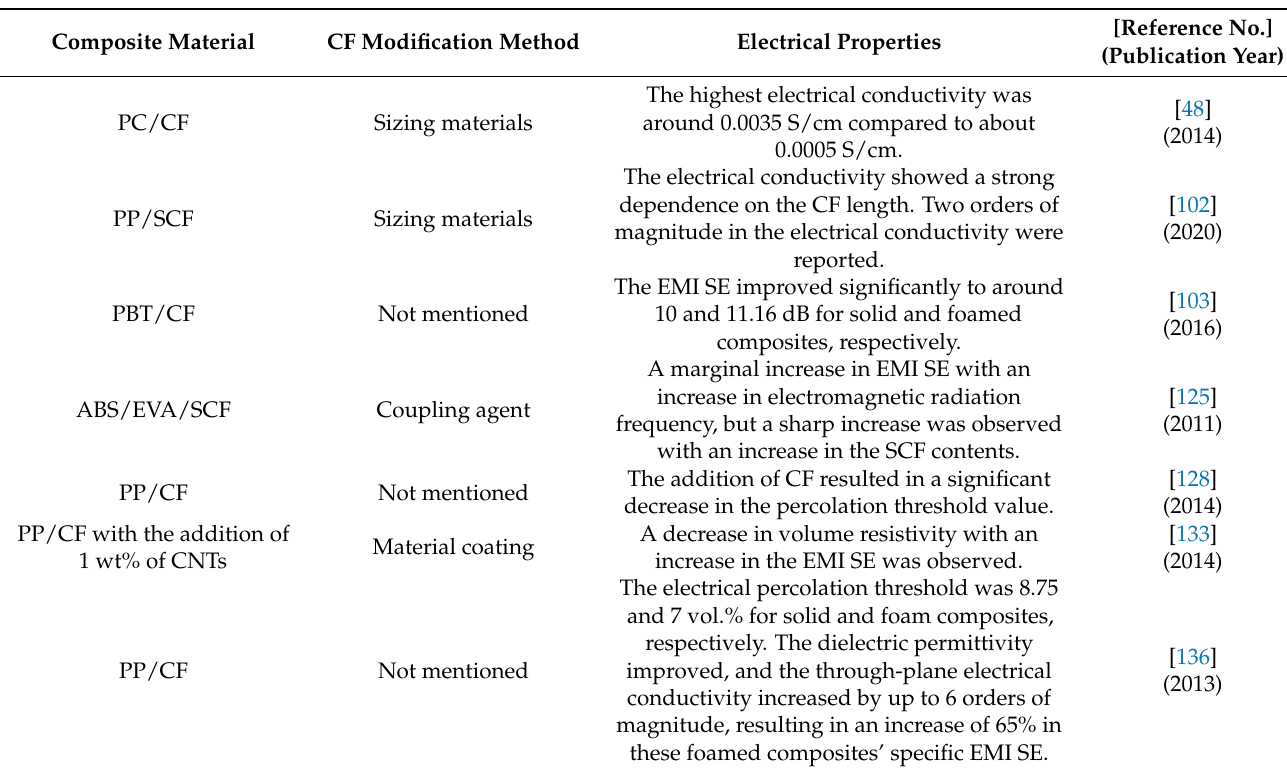
Table 3. The type of thermoplastic polymer and CF, modification techniques of CF, and electrical properties of a variety of CFRTP